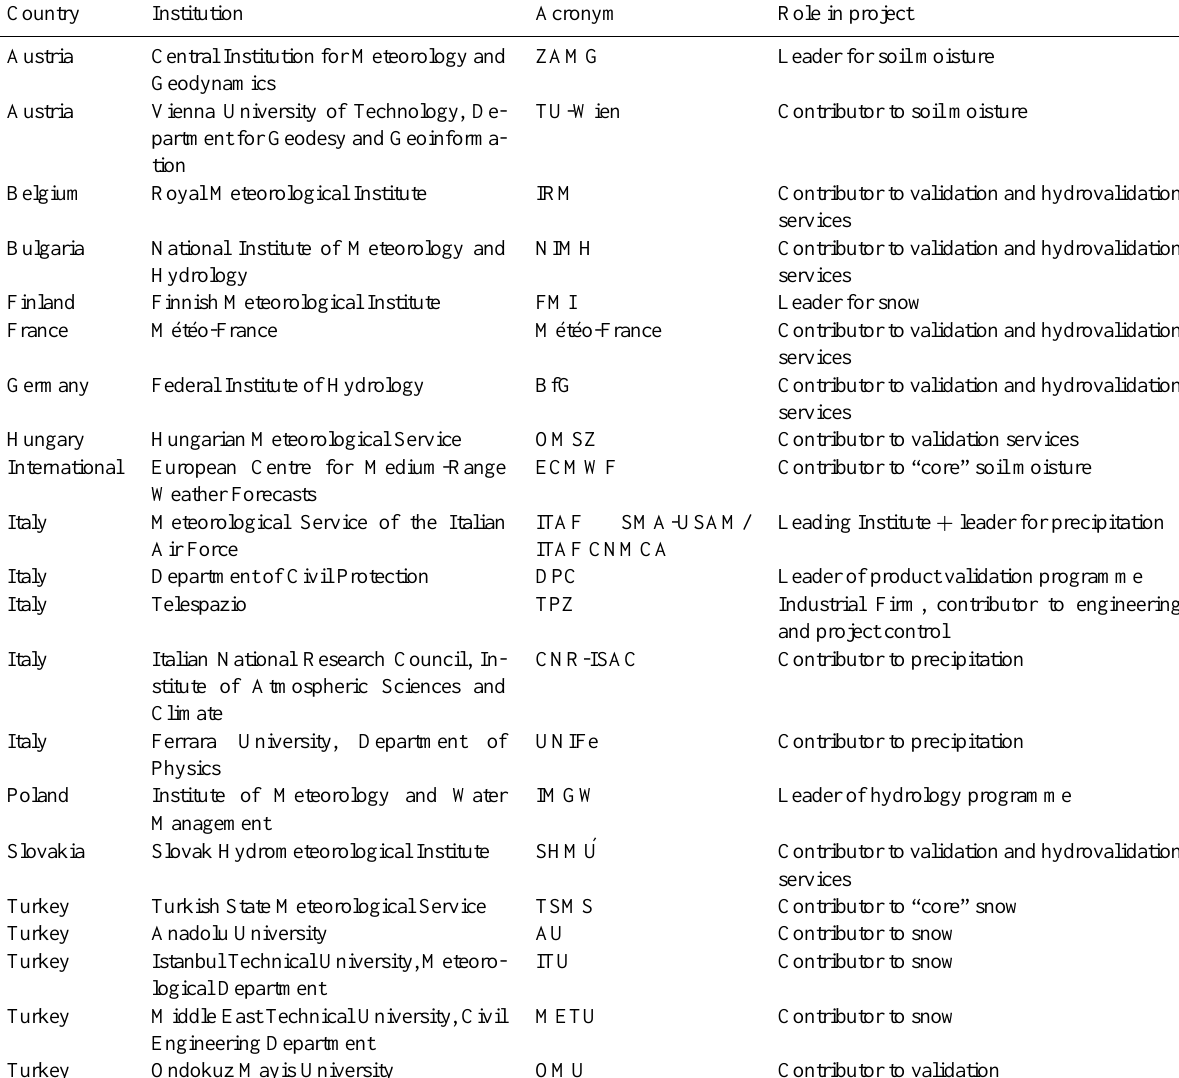
Table 1. Composition of H-SAF Consortium (organized in alphabetical order of participating